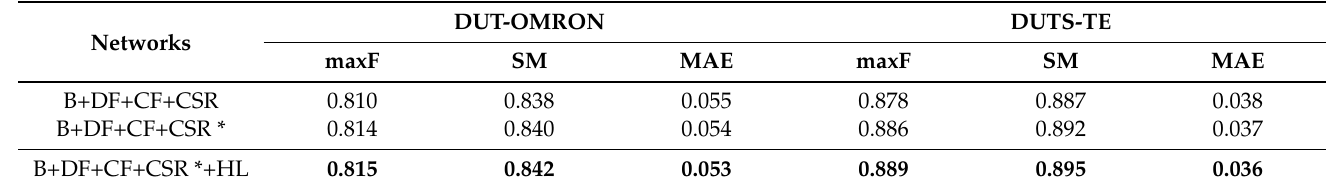
Table 5. Ablation analysis on the effectiveness of the CSRU module. “CSR” refers to the CSRU without any CI supervision, and “CSR *” refers to the supervision of both saliency and CI. We observe that the performance improves as the different components of our model are attached. “DF”, “CF”, and “HL” are the abbreviations for the DFEU, CFEU, and hybrid loss,